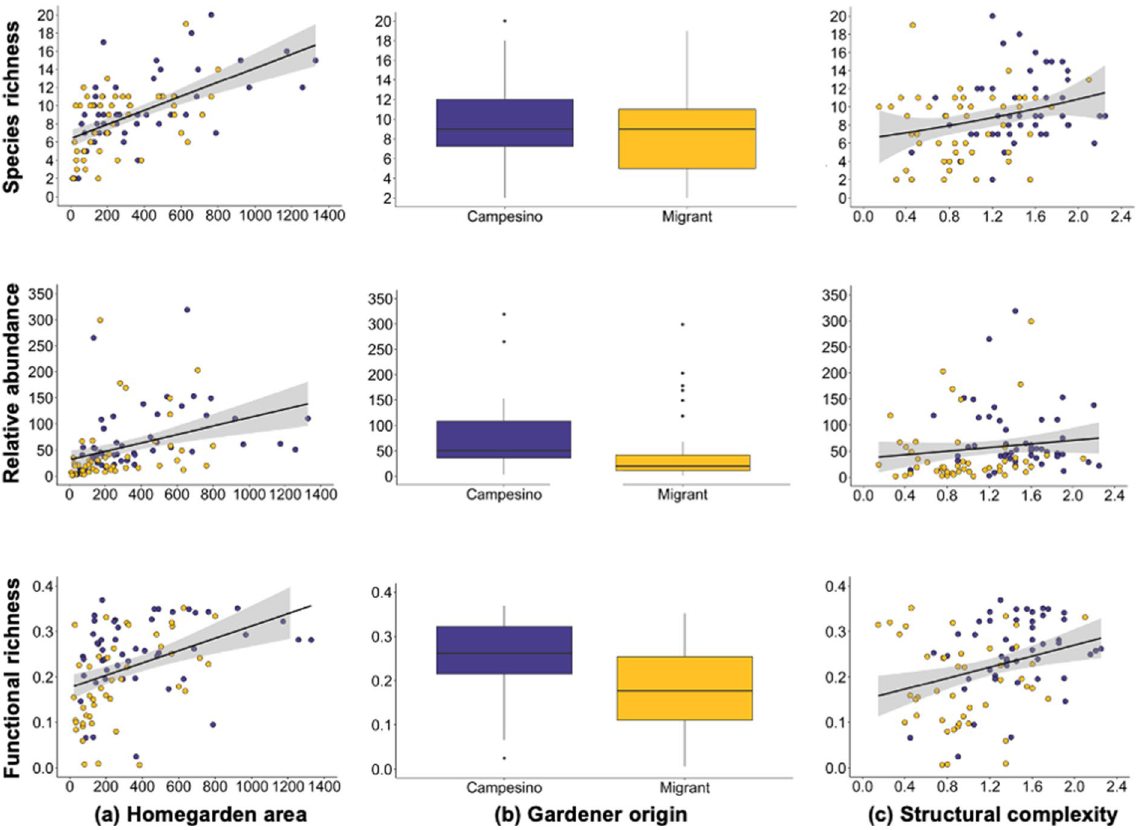
Figure 2. Response of beetle species richness (number of species per homegarden), relative abundance (total number of individuals per homegarden), and functional richness (FRic value) to the most influential social- ecological filters in homegardens, including ( a ) homegarden area, ( b ) gardener origin, and ( c ) homegarden structural complexity in Andean temperate ecosystems, southern Chile. Graphs were generated using R software version 4.0.4 (R Core Team, 2021. R: A language and environment for statistical computing. R Foundation for Statistical Computing, Vienna, Austria. https:// www. Rproj ect.